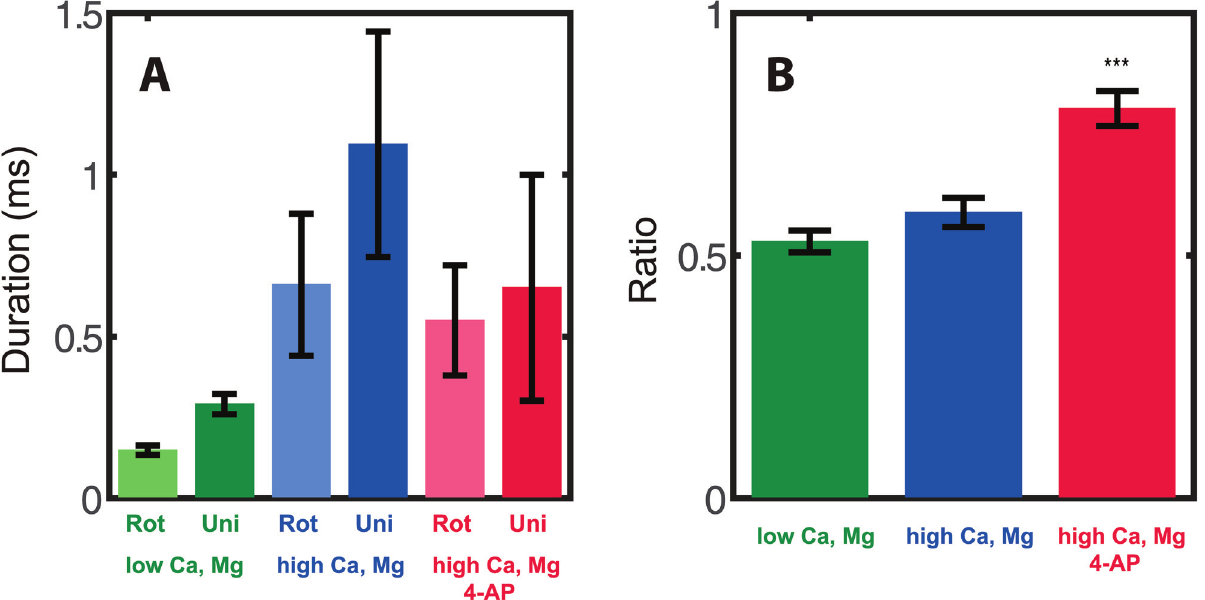
Fig 6. Comparison of excitation with a rotating vs. uni-directional field with and without the A-type channel blocker 4-AP. (A) Pulse durations needed for excitation with rotating (light green) vs. uni-direction (dark green) for [Ca2+] = 1 mM and [Mg2+] = 1 mM, similarly for [Ca2+] = 4 mM and [Mg2+] = 2 mM (center, light and dark blue) and for [Ca2+] = 4 mM and [Mg2+] = 2 mM with addition of 2 mM 4-AP (right, light and dark red). The effect of the change in concentration of ions is to decrease the membrane voltage, countering the increased excitability caused by blocking the A-type channels, which causes the durations needed to be overall about four times longer with higher ionic concentrations. (B) The ratios between durations needed for excitation with a rotating pulse and a uni-directional pulse for the three conditions measured: low concentrations of [Ca2+] and [Mg2+] (green), high concentration of [Ca2+] and [Mg2 +] (blue), and high ionic concentrations with the addition of 4-AP (red). Addition of calcium and magnesium does not affect the ratio. Addition of 4-AP does shorten the duration of the uni-directional field but not of the rotating